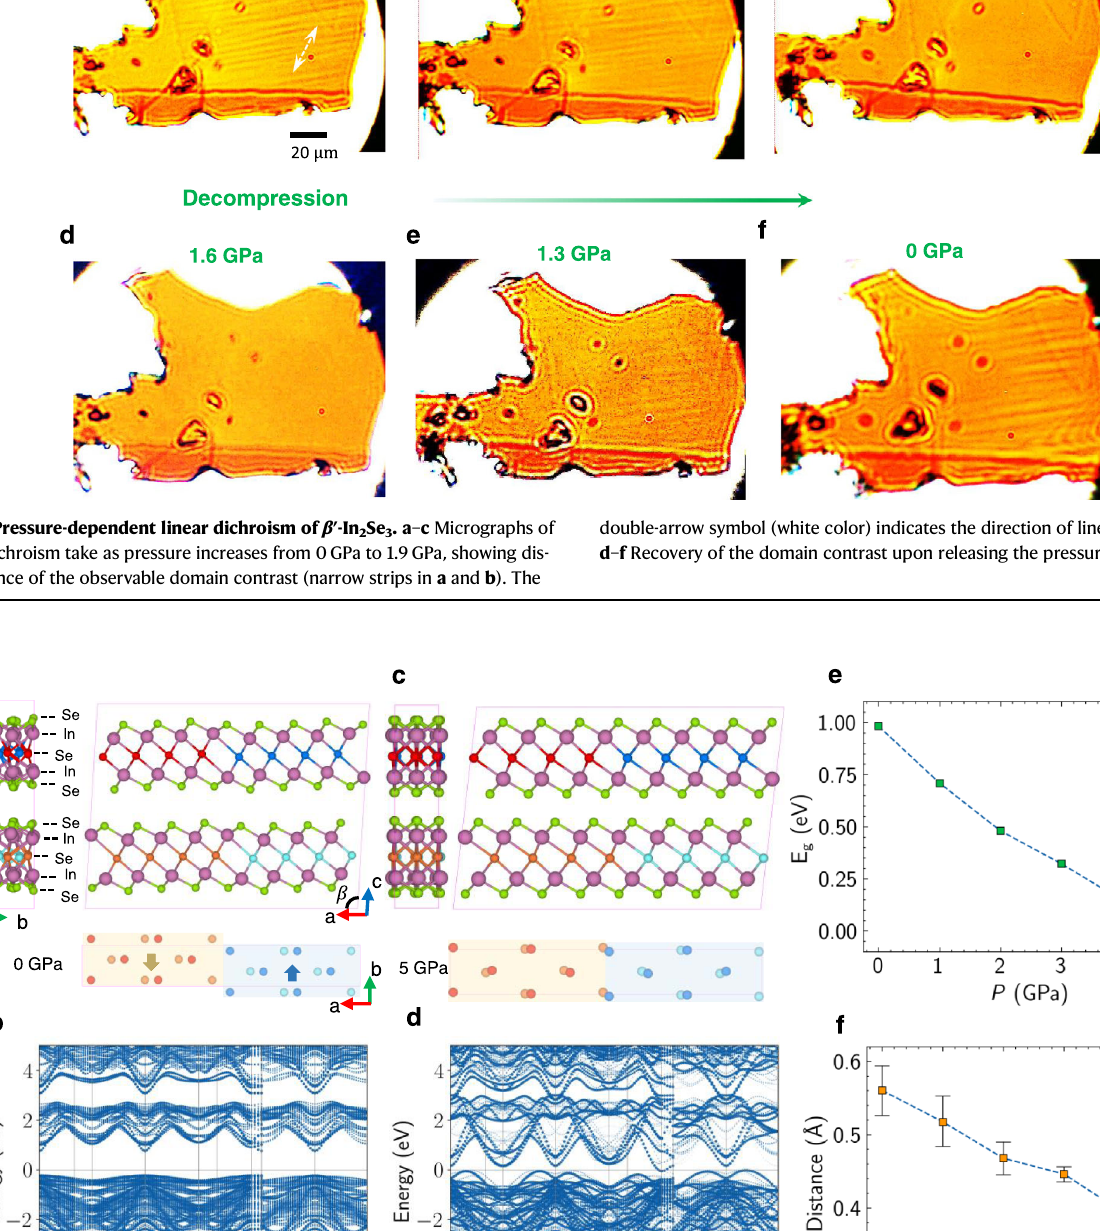
Fig. 4 | Density functional theory calculationsfor pressure induced changesin band structure. a, c Calculated atomic structures, and b, d band structures of β ′ - In 2 Se 3 at 0GPa and 5GPa, respectively. The bottom panels in a and c only plot themiddleSeatoms.Thelargesolidarrowsin a indicateferroelectricdipoleswhich disappear at 5GPa since it becomes semimetal. e Evolution of band gap ( E g ) as a